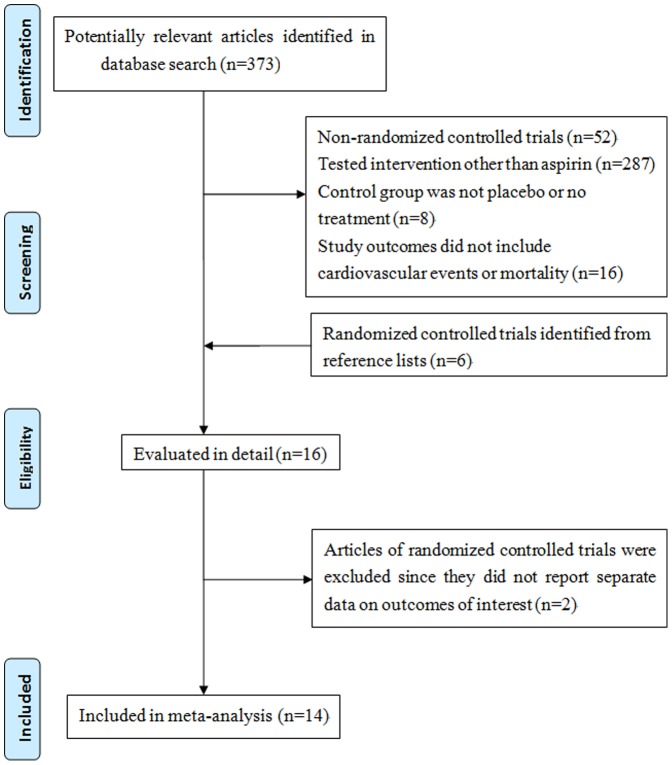
Flow chart of articles selection for this systematic review and meta-analysis.